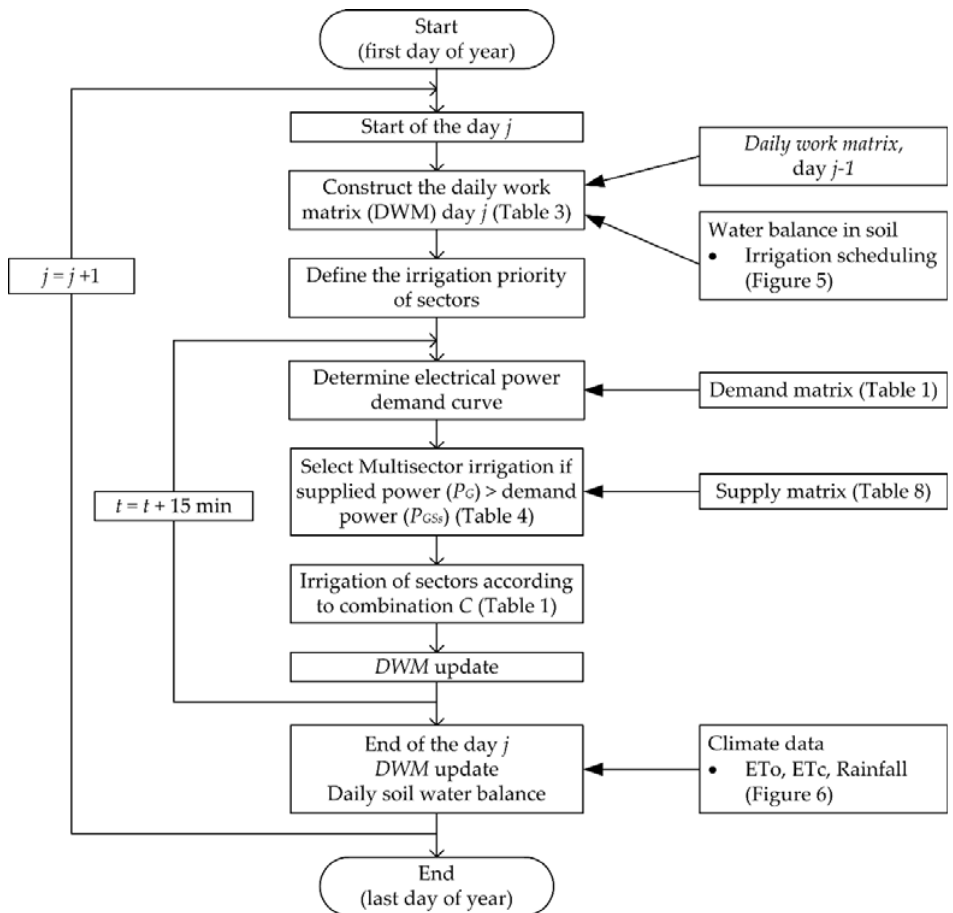
Figure 3. Flowchart of the methodology.